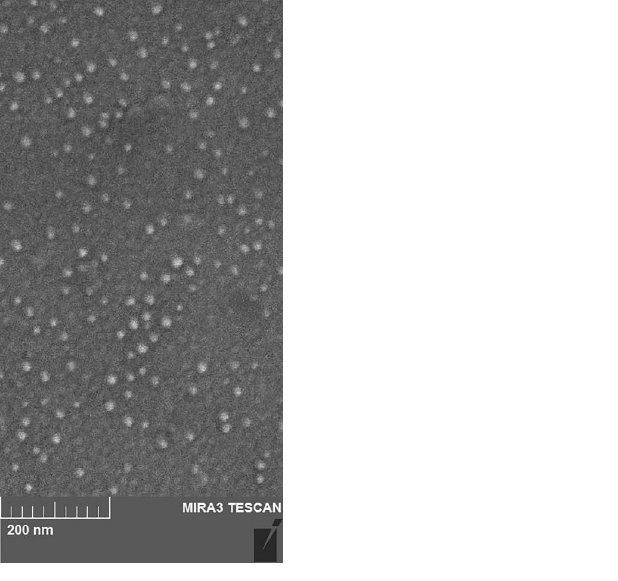
Fig 1. SEM image of